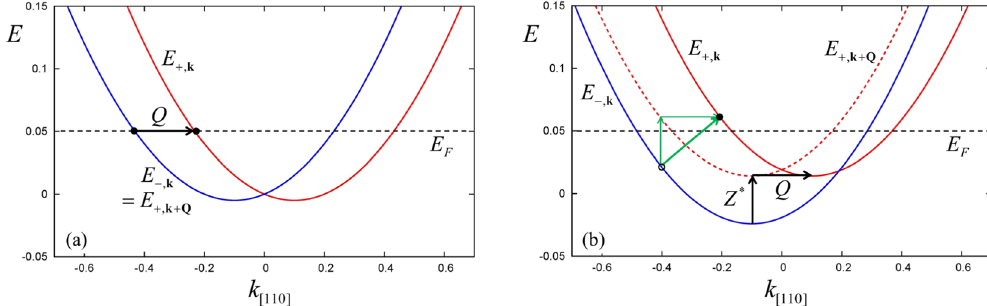
Figure 2. Single-particle energies E − , k and E + , k for α = 0.05 and k along the [110] direction, see Eq. (13). ( a ) No magnetic field ( Z * = 0). Linear combinations of E − , k and E + , k + Q states have spin helix texture, but these cancel out if summed over all occupied states below E F . A persistent spin helix appears if a quasiparticle is injected at the Fermi surface, as shown. ( b ) Finite magnetic field ( Z * = 0.0381). Single-particle excitations across the Fermi energy with momentum transfer Q (thick green arrow) give rise to propagating spin